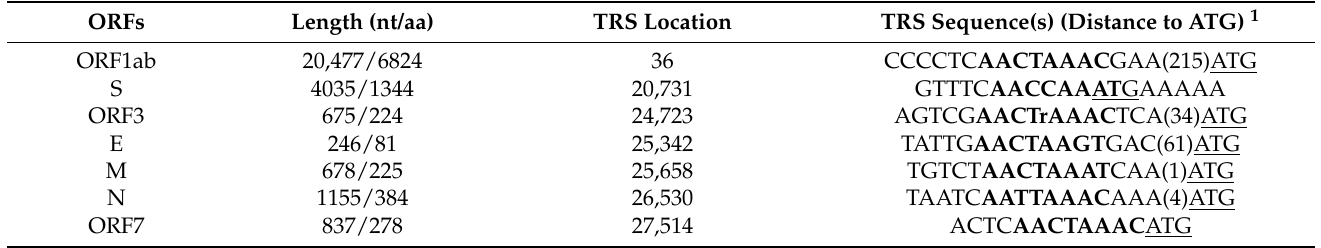
Table 1. ORFs and TRS locations of novel coronavirus strain HCQD-2020.